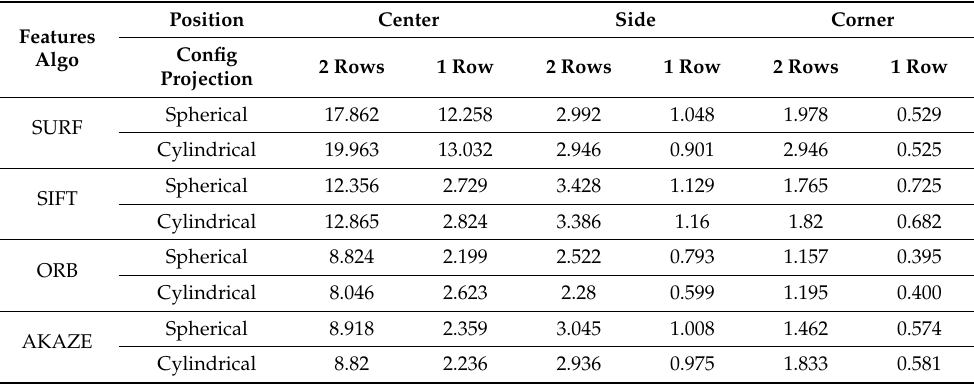
Table 8. Stitching time of different feature-finding